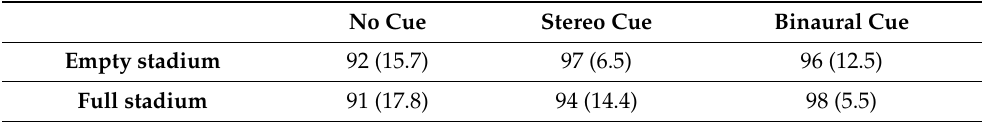
Table 1. Mean target hit rate (and standard deviation) for the two stadium conditions (empty and full) and three cue conditions (binaural, stereo, no cue) for 17